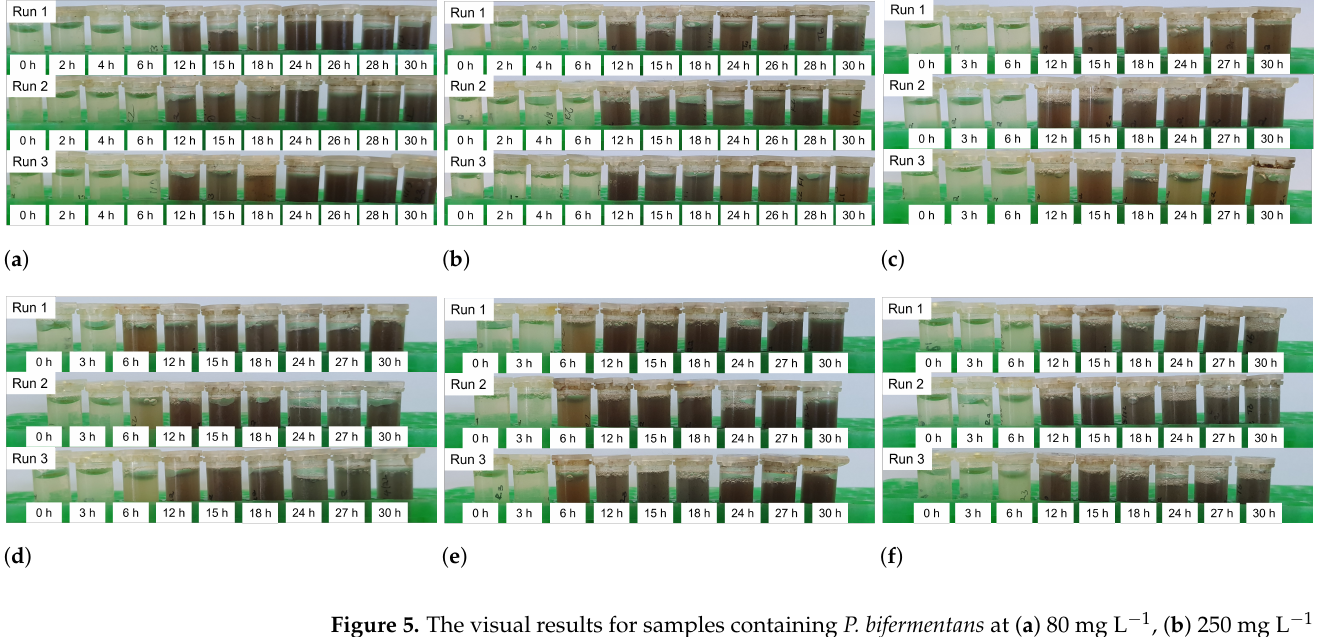
Figure 5. The visual results for samples containing P. bifermentans at ( a ) 80 mg L − 1 , ( b ) 250 mg L − 1 and ( c ) 500 mg L − 1 initial Pb(II) concentration and samples containing K. pneumoniae at ( d ) 80 mg L − 1 , ( e ) 250 mg L − 1 and ( f ) 500 mg L − 1 initial Pb(II) concentration.